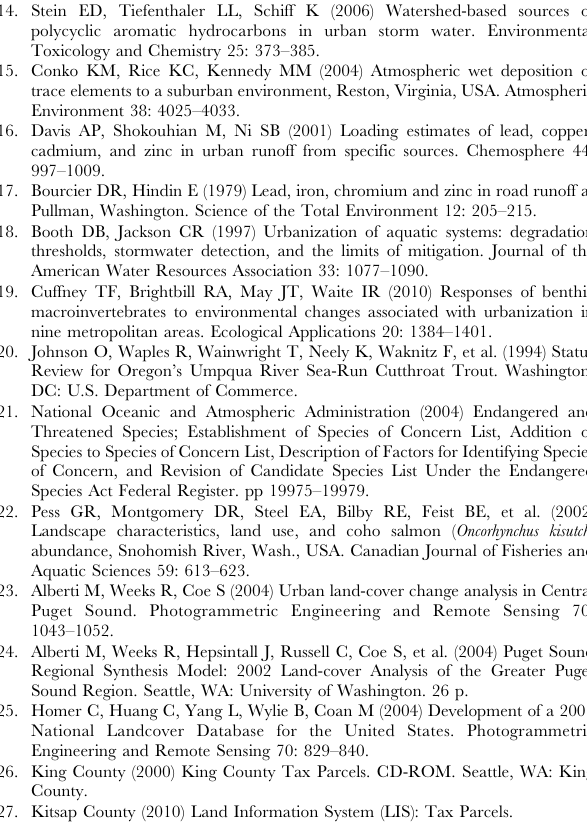
Figure 3. Predictive map of modeled coho spawner mortality rates within the Puget Sound lowlands. Mortality rates are a function of the proportion of key landscape variables within a given basin. Green, yellow and red areas indicate basins with predicted rates of spawner mortality (as a percentage of total fall runs) of , 10%, 10–50%, and . 50%, respectively. Black dots denote locations of the six study sites that were the basis for this analysis. Thick dashed black line depicts the southern boundary of the coho salmon Puget Sound/Georgia Basin Evolutionarily Significant Unit (ESU). Basins that do not have documented presence of coho salmon [38] are not represented on the map, even if they have landscape conditions associated with coho spawner mortality. Key for site numbers: 1=Des Moines; 2=Fauntleroy; 3=Fortson; 4=Longfellow; 5=Piper’s; and, 6=Thornton Creek.